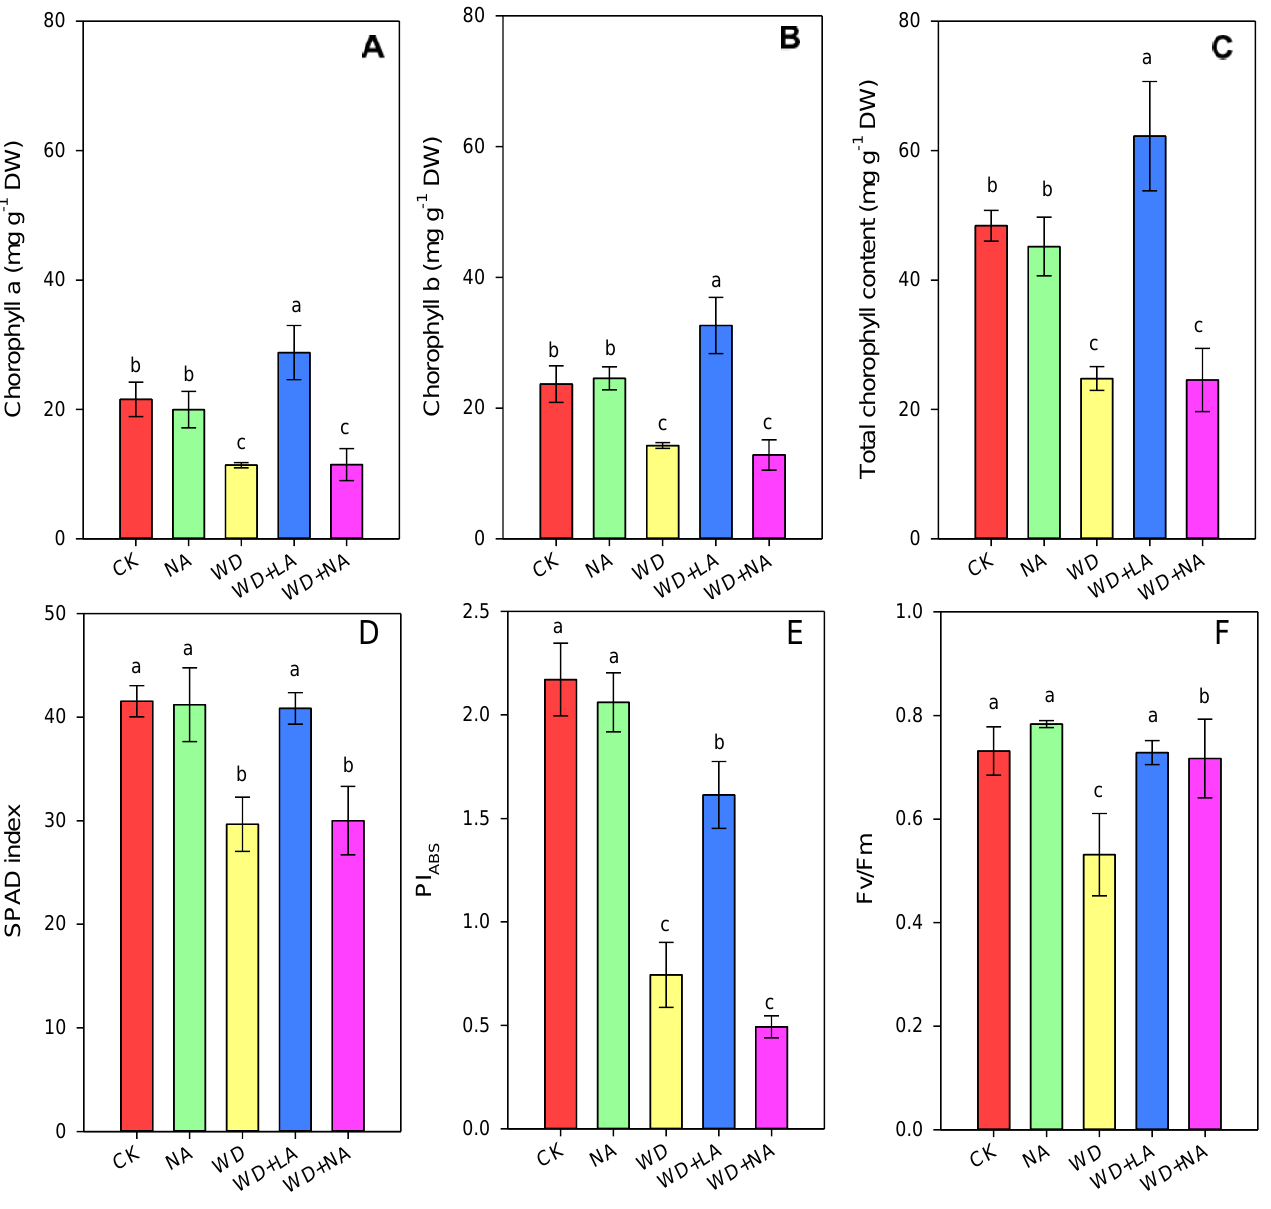
Figure 4. Chlorophyll a ( A ), chlorophyll b ( B ), total chlorophyll ( C ), SPAD index ( D ), PI ABS ( E ), and Fv/Fm ( F ) of maize seedlings under drought stress conditions. CK: control treatment; NA: 25 µ mol L − 1 of L-NAME; WD: 20% PEG; WD + LA: 20% PEG + 150 µ mol L − 1 of L-arginine; WD + NA: 20% PEG + 25 µ mol L − 1 of L-NAME. The results are presented as the means ± standard error ( n = 3). Significant differences are represented by lowercase letters ( p ≤ 0.05) based on the LSD test. Lowercase letters above the error bars in ( A – F ) indicate significant differences among the five treatments ( p < 0.05). L-NAME, N γ -nitro-L-arginine methyl ester; PEG, polyethylene glycol; PIABS, performance index on an adsorption basis.